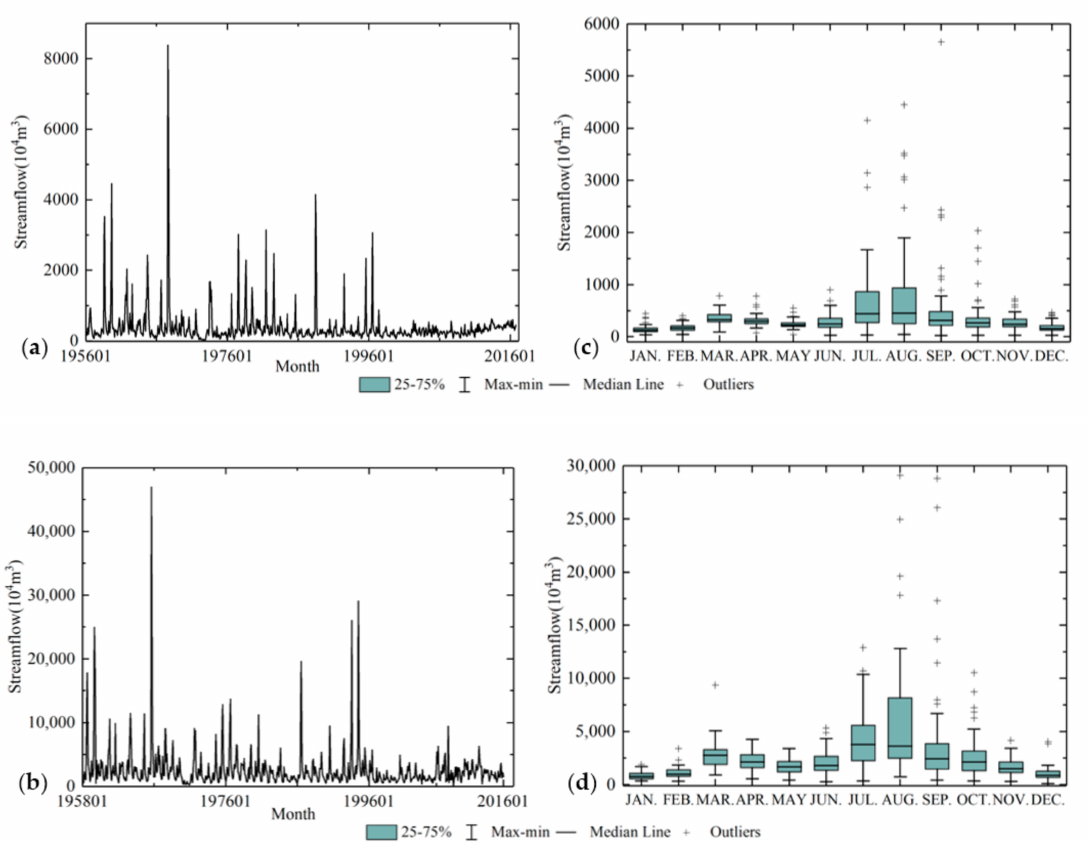
Figure 7. Monthly streamflow data at the Shangjingyou station and the Fenhe station. ( a ) Monthly streamflow for Shangjingyou station; ( b ) Boxplots of streamflow for Shangjingyou station; ( c ) Monthly streamflow for Fenhe reservoir station; ( d ) Boxplots of streamflow for Fenhe reservoir